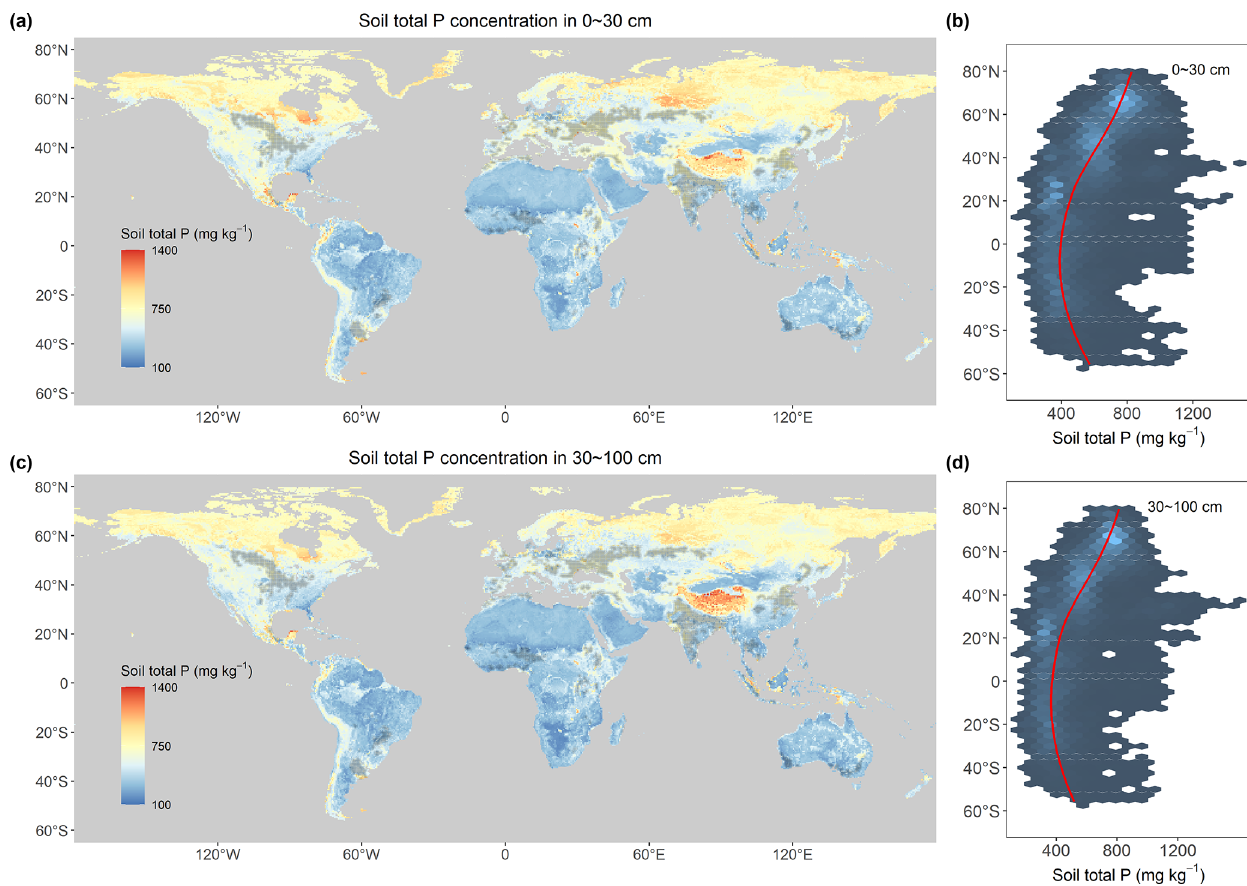
Figure 5. Global maps of total P concentration in the 0–30 and 30–100cm layers of soils. Panels (a) and (b) are maps of topsoil (0–30cm) total P concentration and the latitudinal patterns, respectively. Panels (c) and (d) are maps of subsoil (30–100cm) total P concentration and the latitudinal patterns, respectively. Red lines in panels (b) and (d) indicate the locally weighted regressions between latitude and soil total P concentration in the precited global map. Note that we did not remove cropland or any other heavily influenced areas from the predicted maps, so they can be used to represent soils without essential anthropogenic activities. In this figure, we used gray cells to indicate grid cells with more than 50% of areas comprising cropland. A map without the cropland symbols is visible in Fig.